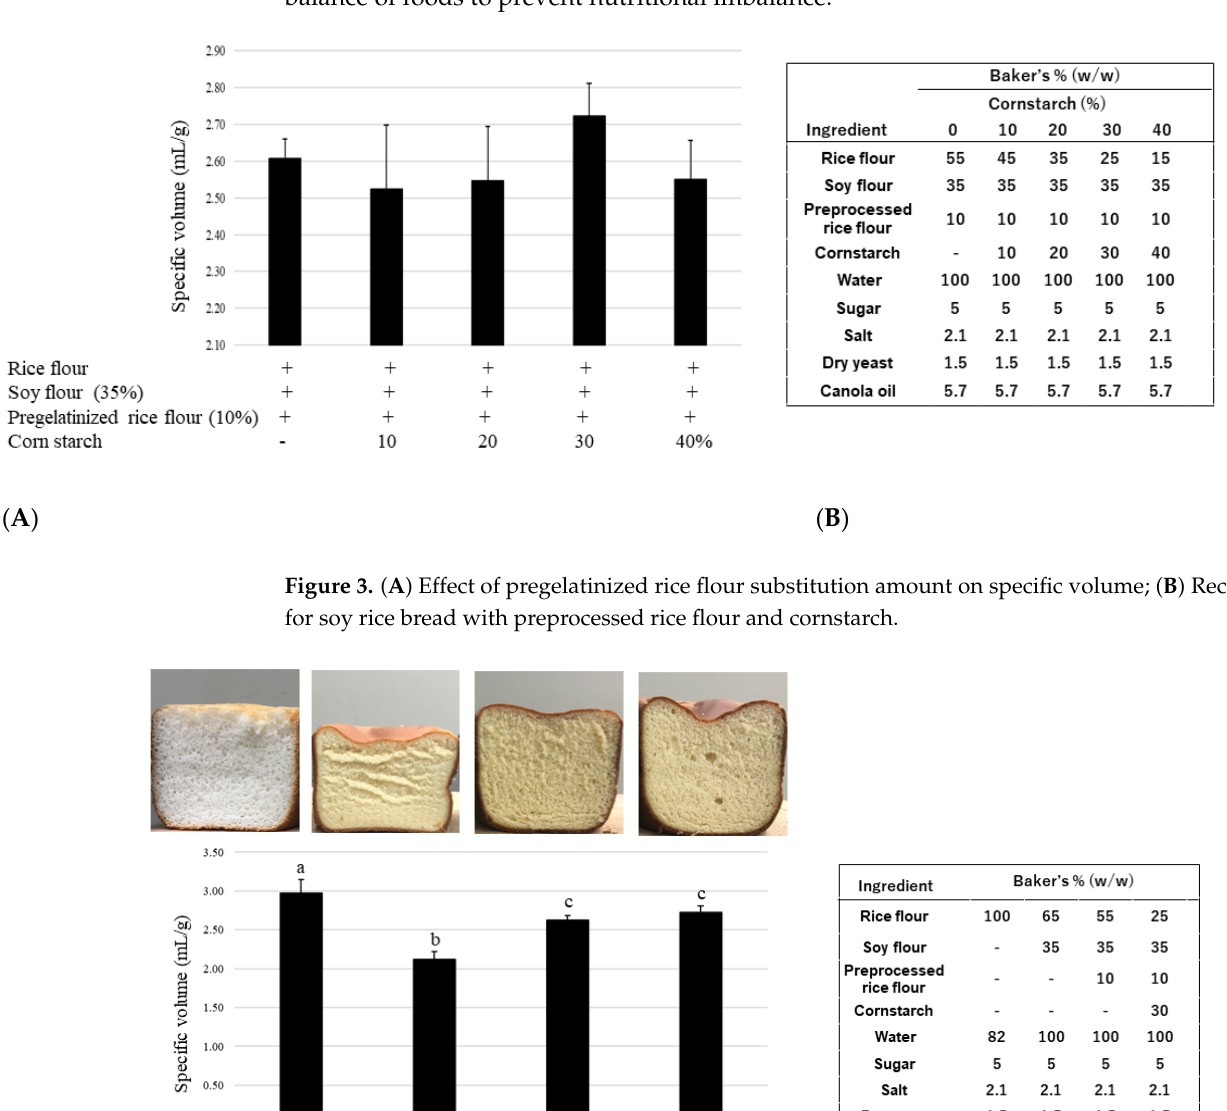
Foods 2023 , 12 , x FOR PEER REVIEW